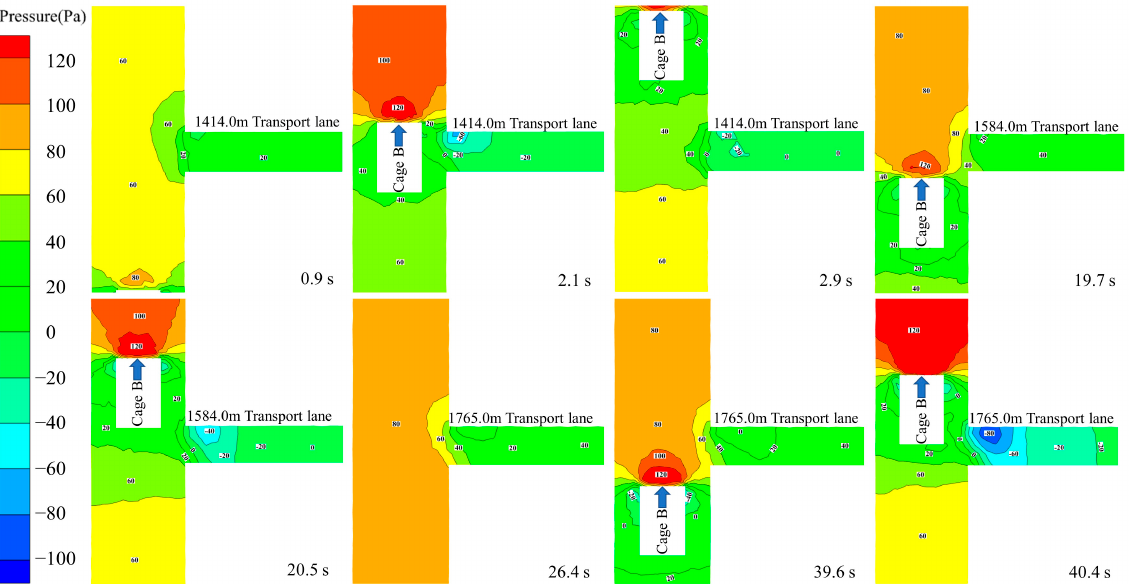
Figure 9. The time-varying curve of piston wind speed at each measuring point in different transport lane s: ( a ) 1765.0 m transport lane, ( b ) 1584.0 m transport lane, ( c ) 1414.0 m transport lane.